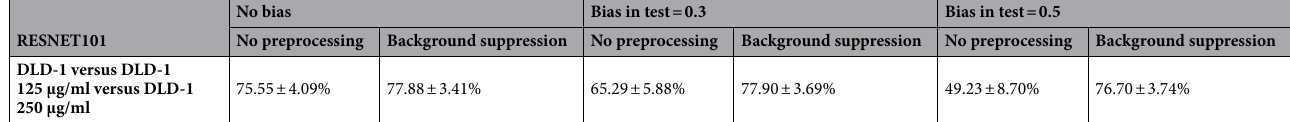
No bias Bias in test = 0.3 Bias in test = 0.5 RESNET101